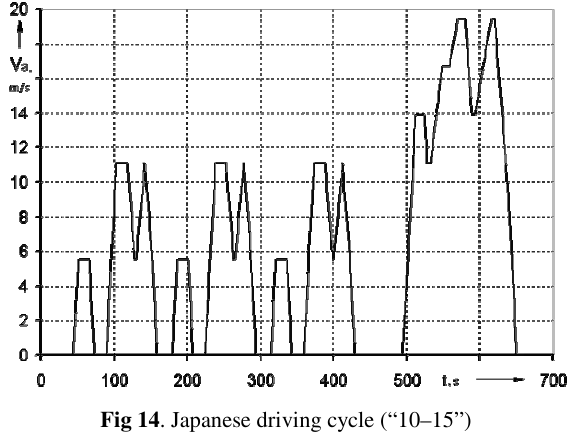
Fig 14 . Japanese driving cycle (“10–15”)